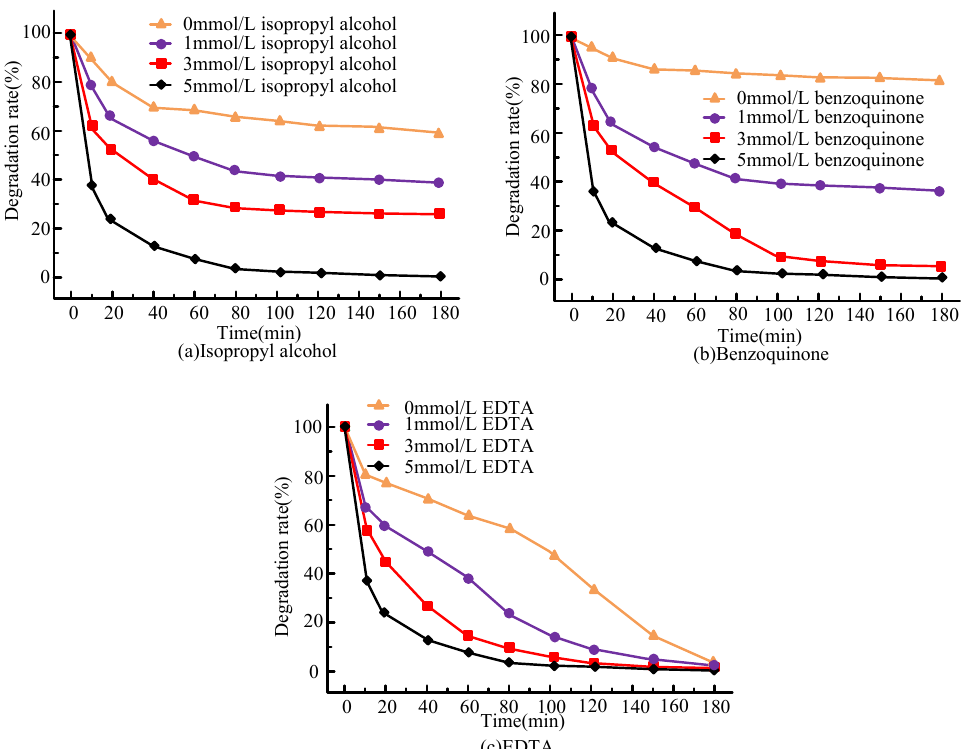
Figure 8. Under optimum conditions the capture agent ( a ) isopropyl alcohol, ( b ) p-benzoquinone, and ( c ) Effect of ethylenediaminetetraacetic acid on the degradation of bisphenol A by catalyst Fe3O4@B-rGO (9.3%).